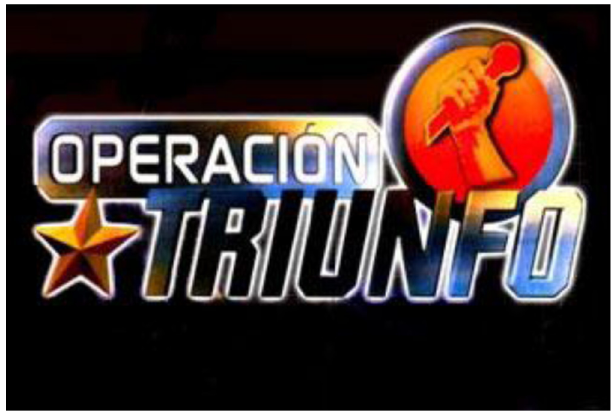
Figure 3. Operacio´n Triunfo 1 – Logo. Source: